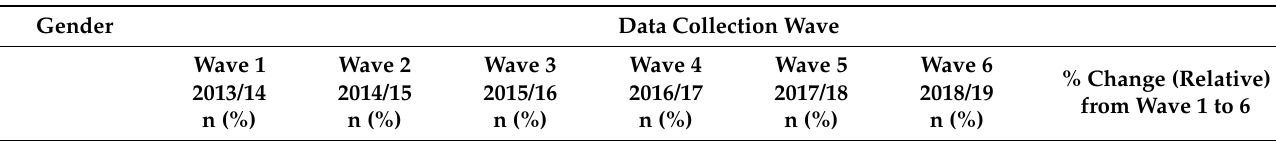
Table 1. Percentage of grade 12 students (n = 44,740) engaging in health risk behaviours by gender and wave, 2013-19 COMPASS